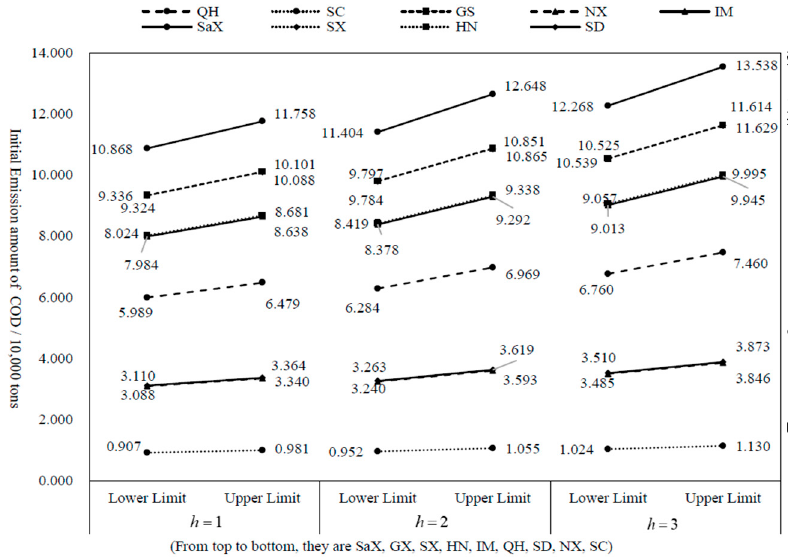
Figure 2. Allocation and variation trend of COD in nine regions in 2030 under different scenarios.